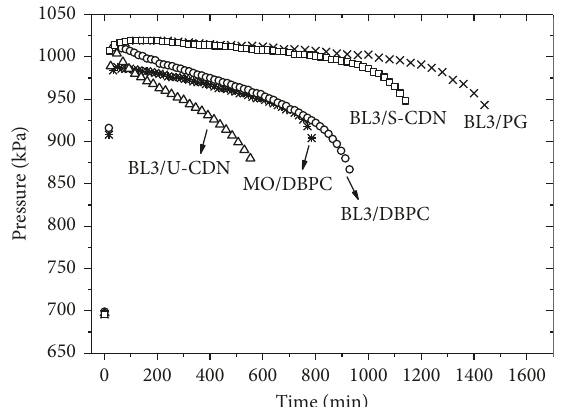
Figure 7: Pressure profiles for accelerated oxidation experiments at 140 ° C with samples of BL3 doped with 4000mg/kg of four anti- oxidants (U-CDN, S-CDN, DBPC, and PG) and for mineral oil doped with DBPC (4000mg/kg).